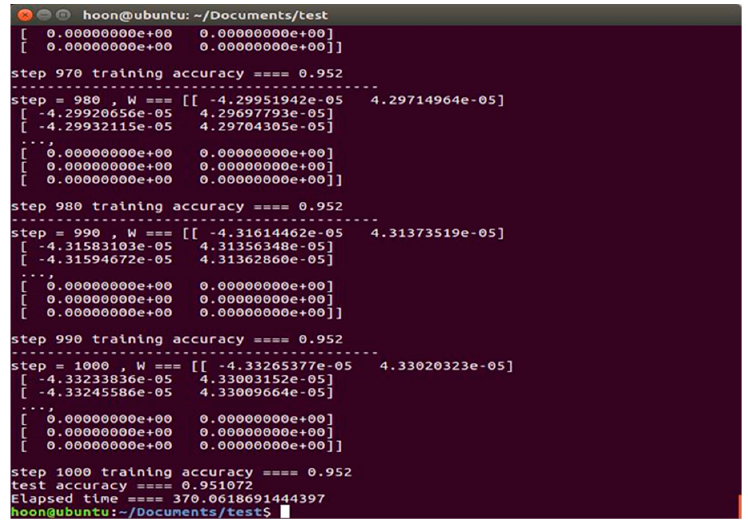
Figure 11. Accuracy and time using the convolutional neural network (CNN).